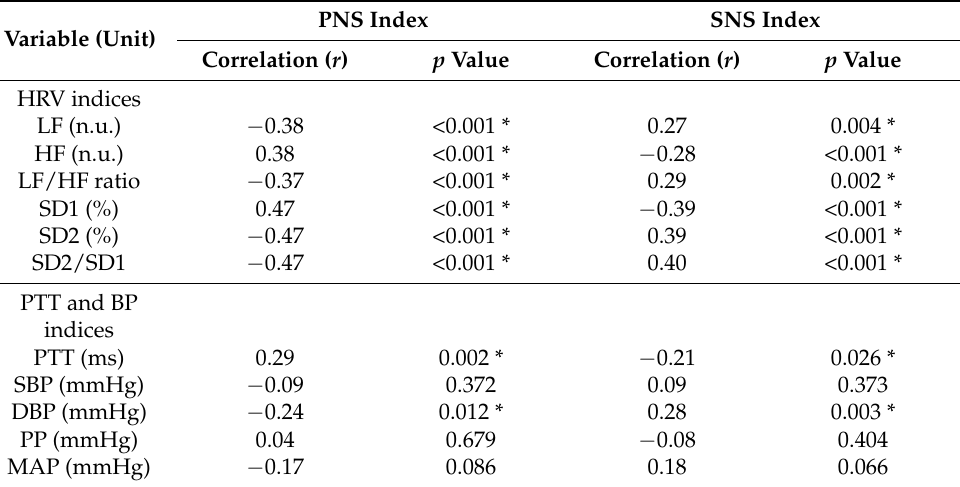
Table 3. A nonparametric partial correlation in all ischemic stroke patients with age and sex